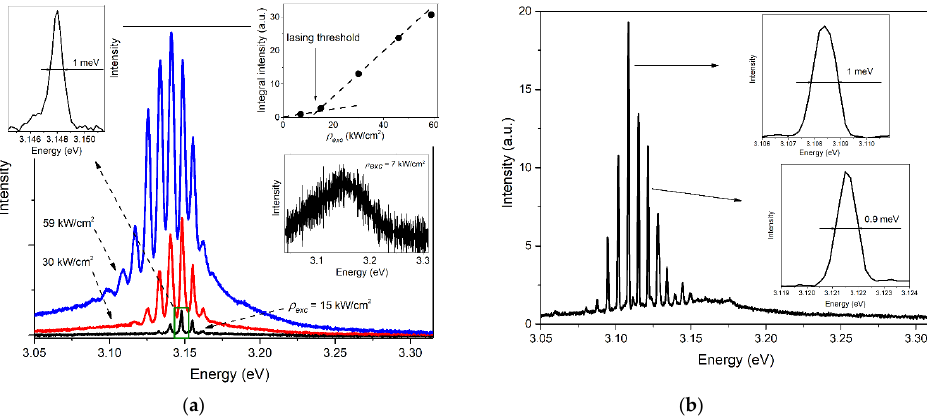
Figure 2. RT lasing spectra of the individual ZnO microrods: ( a ) the evolution of the lasing spectra at different ρ exc ; the left inset shows the laser peak at 3.148 eV; the right bottom inset shows the spectrum at ρ exc = 7 kW/cm 2 ; the right upper inset shows the dependence of the intensity in the maximum of the laser peak at 3.148 eV on ρ exc ; ( b ) the lasing spectrum recorded at ρ exc = 520 kW/cm 2